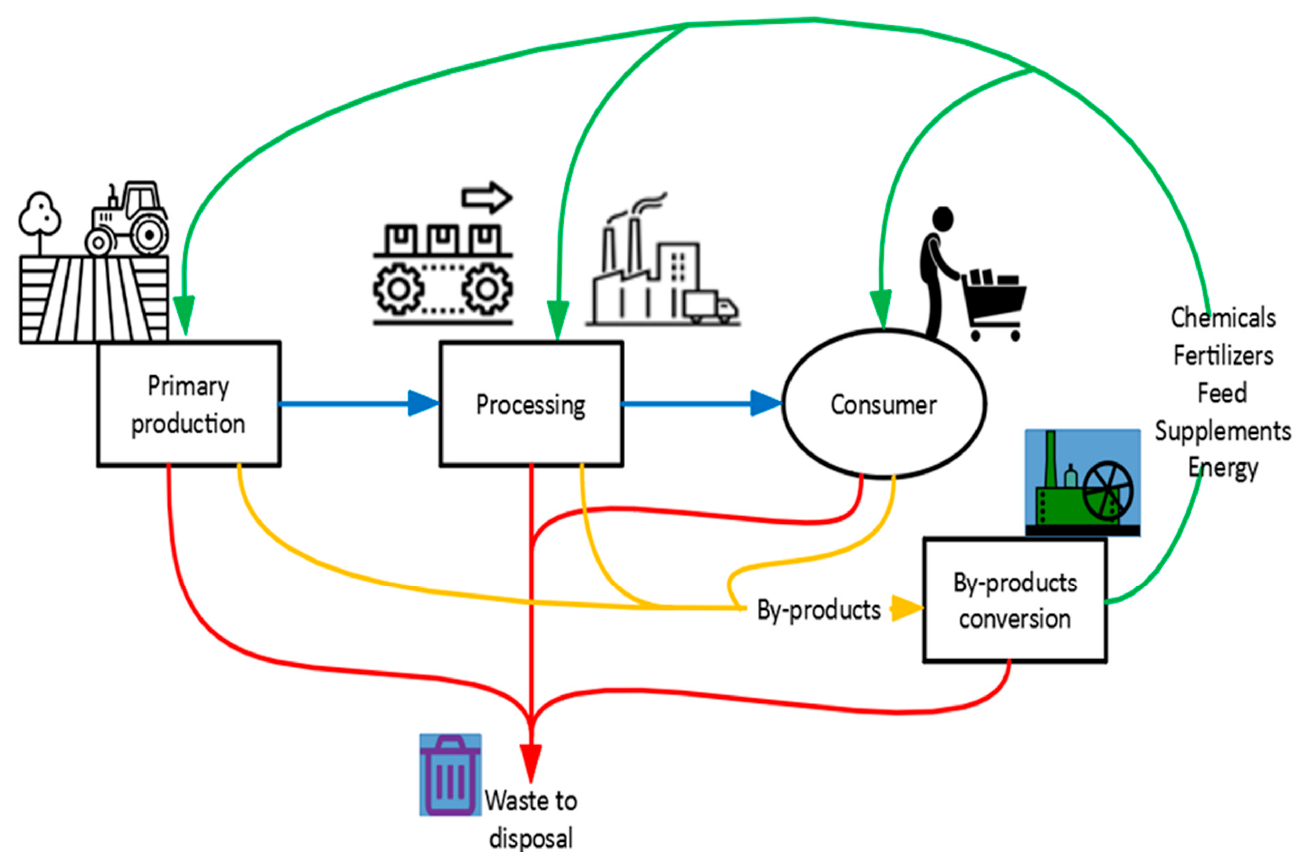
Figure 1. Schematic representation of a system that can integrate the circular economy and green chemistry in a strategic sustainability framework.